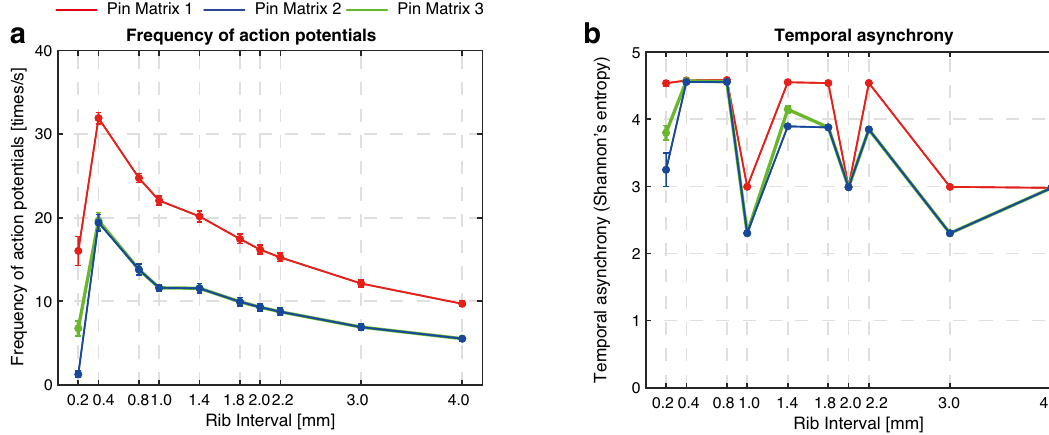
Figure 5. Detailed analysis of numerical results. ( a ) In our model, the sensory neuron responds vigorously to the fishbone patterns when the rib interval is 0.4 mm for all pin matrix conditions. ( b ) Calculated temporal asynchrony of action potentials. There are sudden dips in the calculated values at rib intervals of 1.0, 2.0 and 3.0